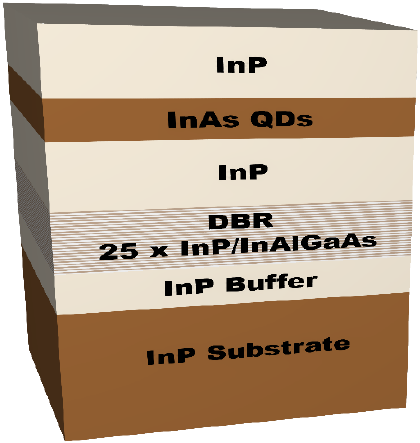
Figure 1. Schematic of the investigated sample structure: InP substrate and buffer layer, a 25-pair distributed Bragg reflector (DBR), and 246 nm thick InP layer below and above nominally two monolayers of InAs forming the self-assembled quantum dots (QDs).